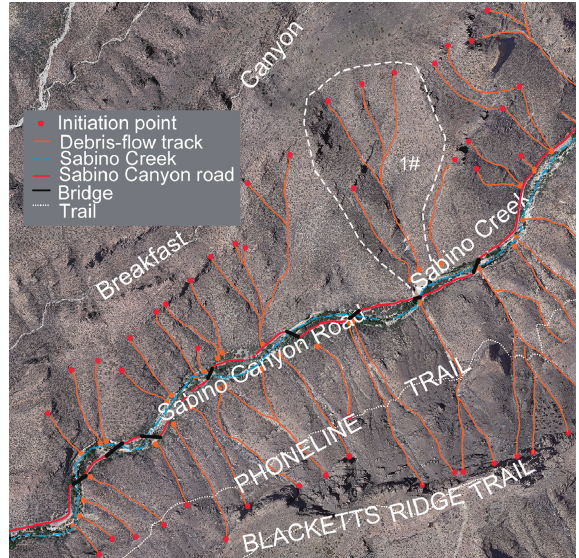
Figure 2: Orthophoto of Sabino Canyon collected in 2015 by PAG (2.56 km 2 area with a 15cm accuracy, edited).